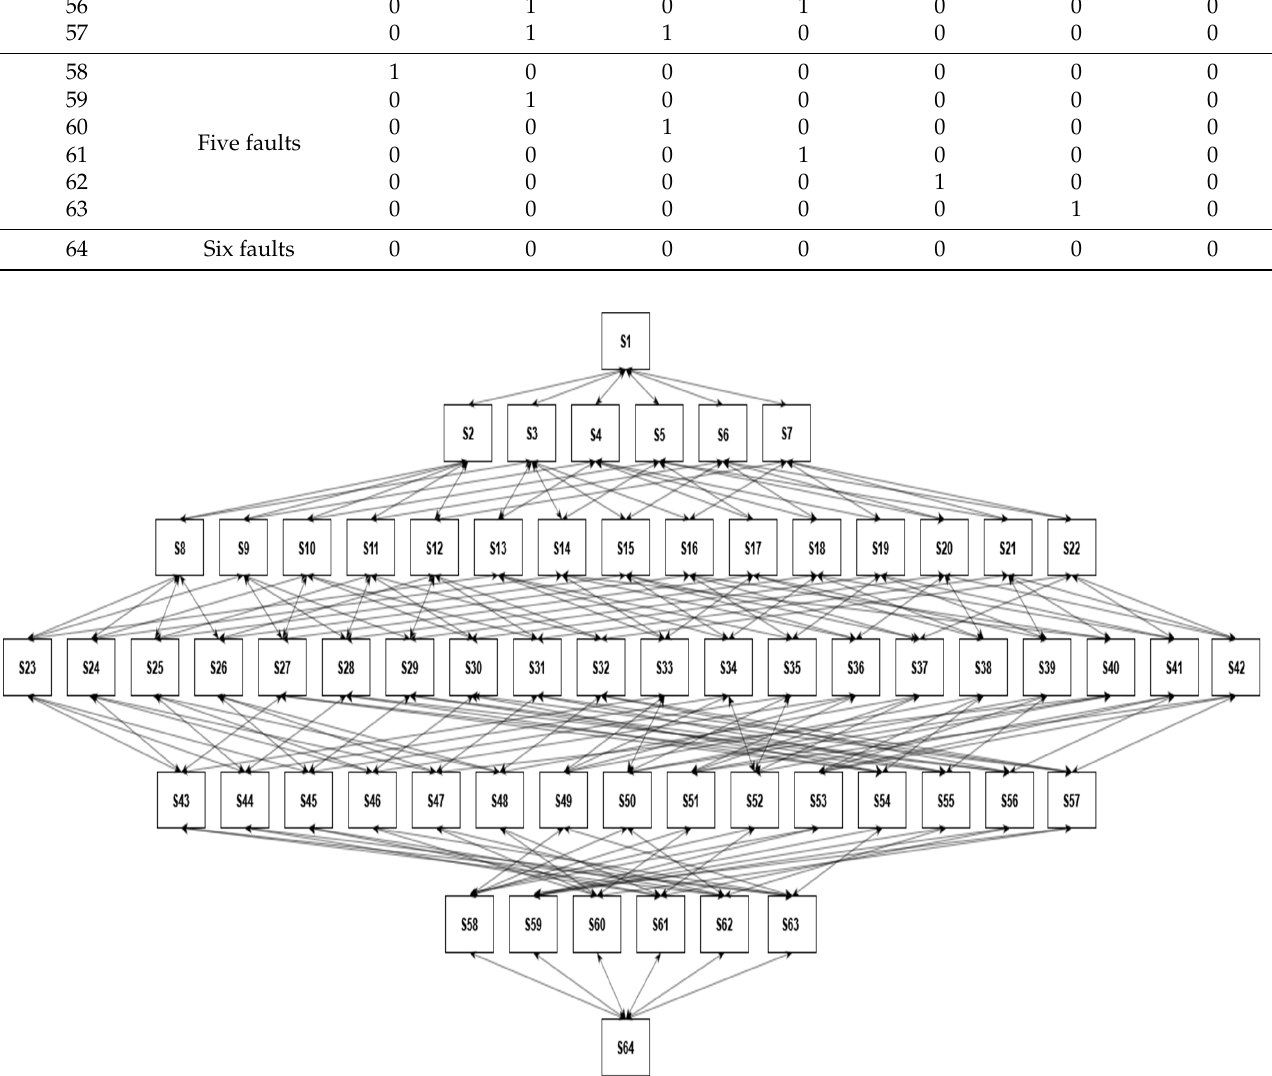
Figure A1. Markov chain of the proposed series parallel HEPS.